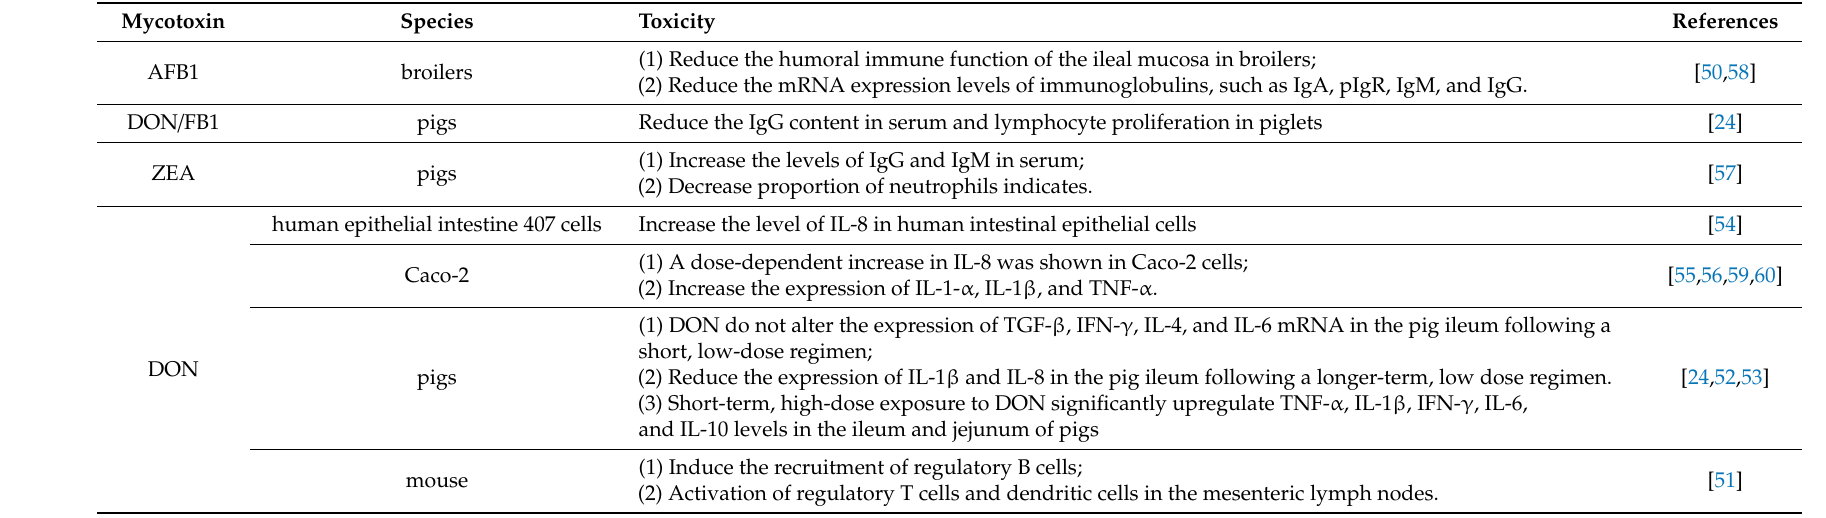
Table 5. Toxicity studies: The toxic e ff ects of mycotoxins on the intestinal mucosal immune